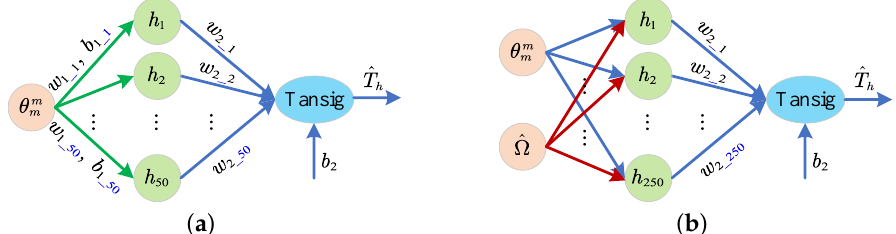
Figure 4. Neural network structure: ( a ) single input with 50 nodes in the hidden layer and ( b ) double inputs with 250 nodes in the hidden